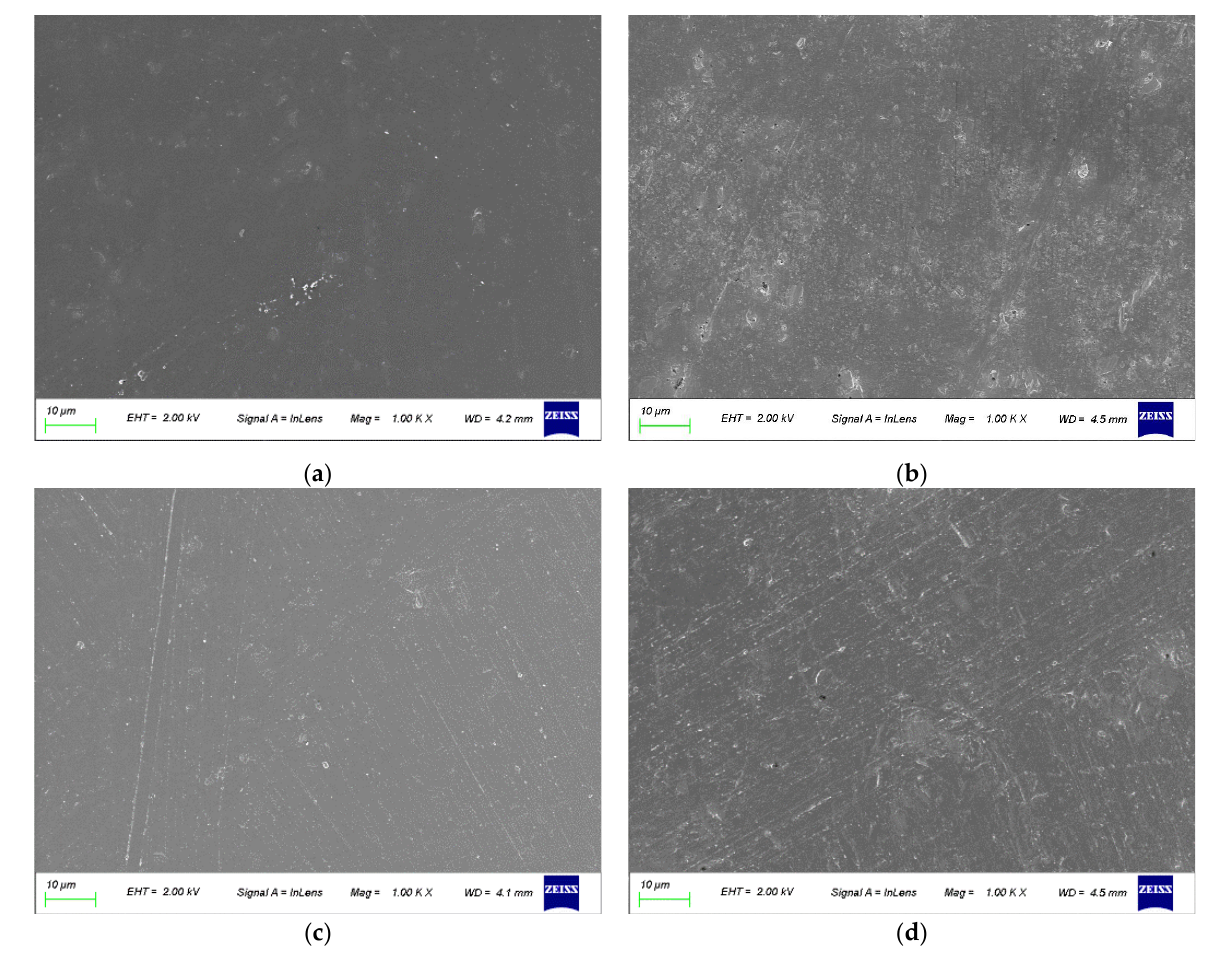
Figure 13. The SEM images of PVC composite materials at different aging times. MgAl2.0/TS – Zn ( a — 0 min; b — 105 min ） and CL-MgAl2.0/TS – Zn ( c — 0 min; d — 105 min). ( a —0 min; b —105 min) and CL-MgAl2.0/TS–Zn ( c —0 min; d —105 min).